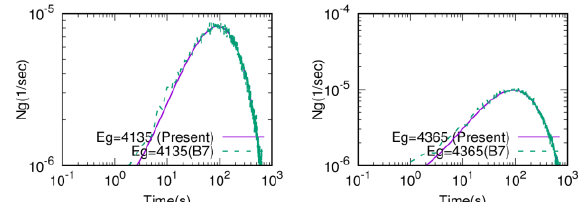
Fig. 3 Calculated BDFGs at E  =4135 and 4365 keV compared with those in ENDF/B-VII.1 for n th + 235 U fission.